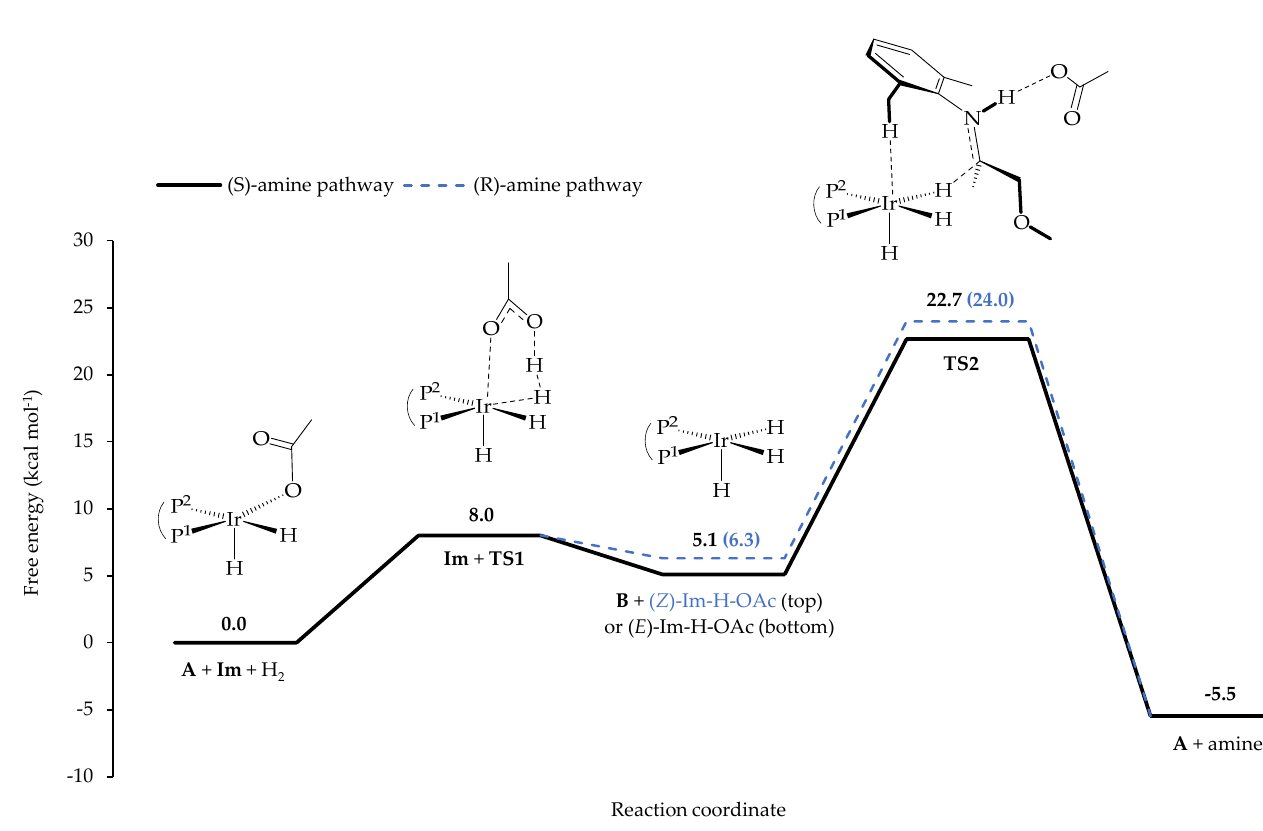
Figure 5. Reaction coordinate diagram and transition states for proposed hydrogenation mechanism in acetic acid.